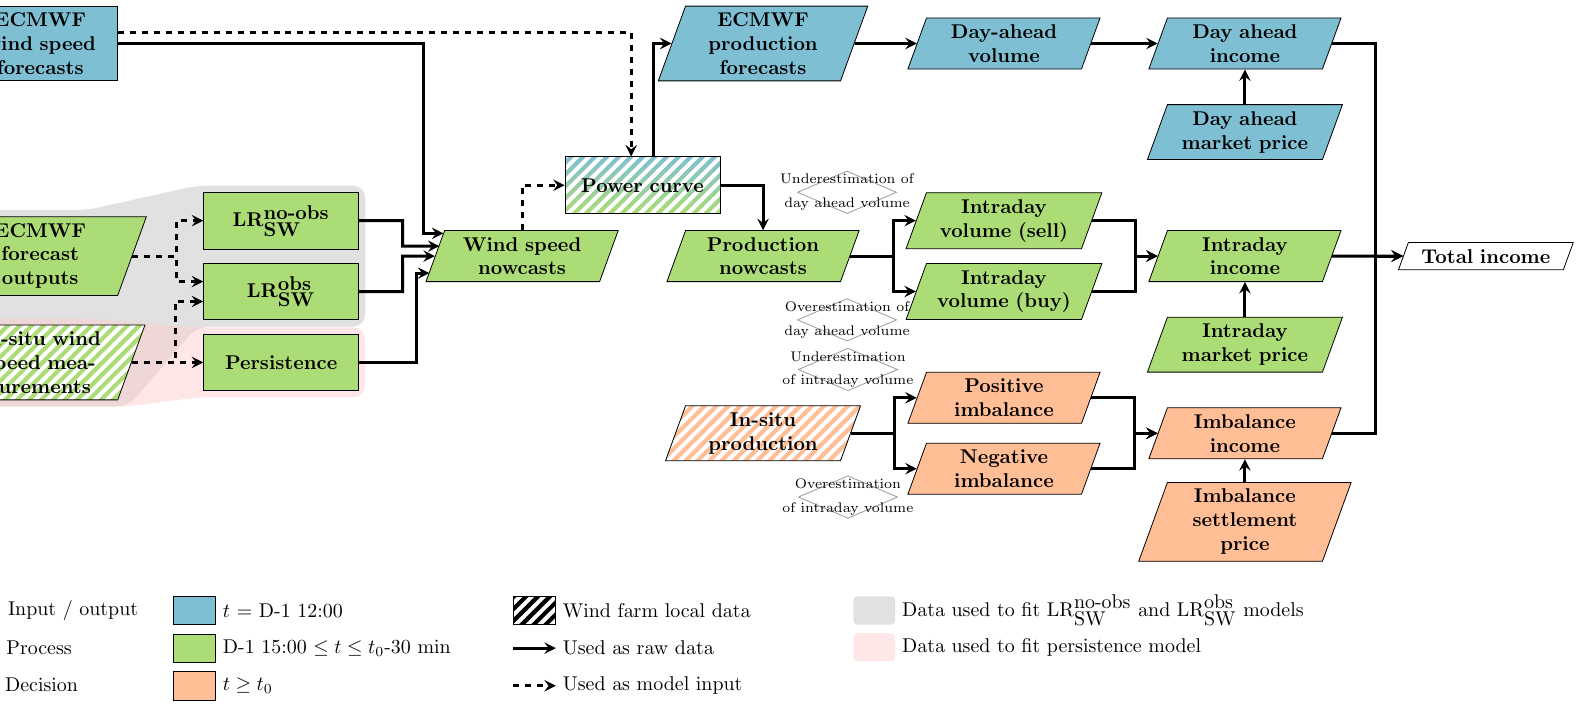
Figure 4. Workflow considered in this